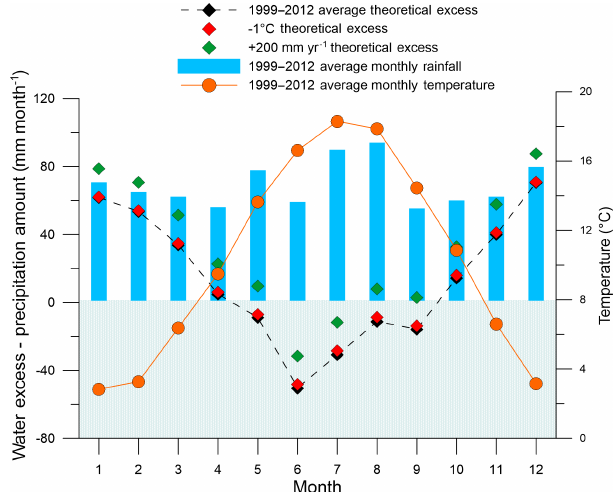
Figure 2. Chart showing the calculated theoretical amount of wa- ter excess calculated with the Thornthwaite equation (Thornthwaite and Mather, 1957), based on temperature and precipitation data near Han-sur-Lesse cave from 1999 to 2012 (Royal Meteorological In- stitute, KMI). X axis represents the months from January (1) to De- cember